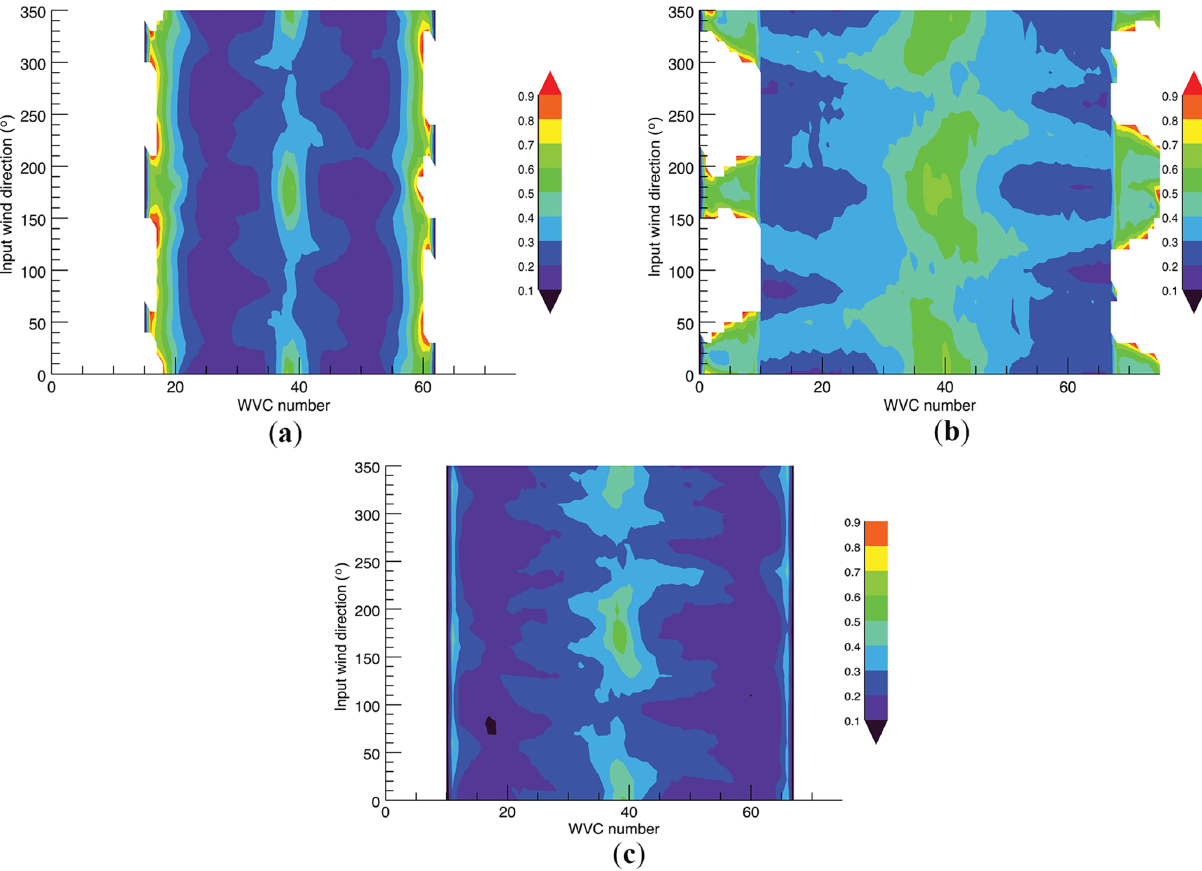
Figure 21. FoM VRMS map as a function of across-track location and wind direction (wind speed is 9ms − 1 ). (a) SCAT. (b) SeaWinds. (c)